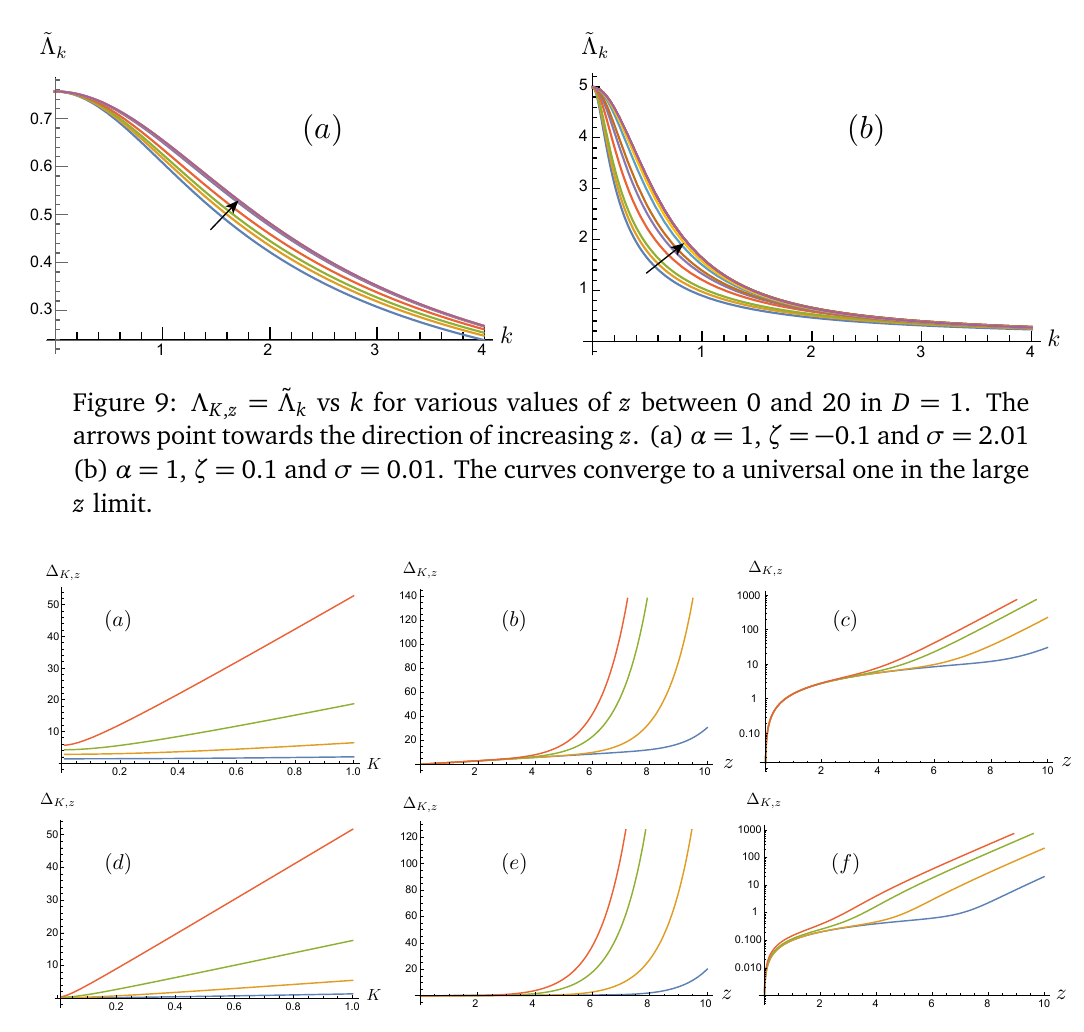
Figure 10: (a) and (d): ∆ plotted as a function of K at z = 1 (blue), z = 2 K , z (orange), z = 3 (green) and z = 4 (red) for (a) ζ = 0.1, σ = 0.01, and (d) ζ = − 0.1, σ = 2.01. (b) and (e): ∆ plotted as a function of z at K = 0.001 (blue), K = 0.01 K , z (orange), K = 0.05 (green) and K = 0.1 (red) for (b) ζ = 0.1, σ = 0.01, and (e) ζ = − 0.1, σ = 2.01. (c) and (f) are (b) and (e) shown in the logarithmic scale. In all plots, we set D = 1 and α =